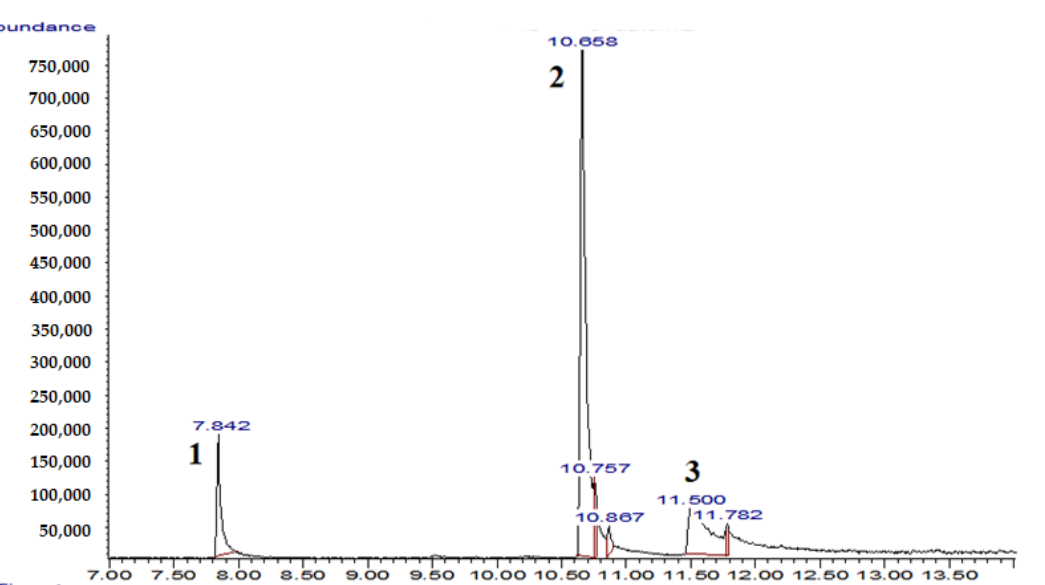
Figure 8. Chromatogram of the extract obtained during biotransformation of (–)-isopulegol (5 days) using R. rhodochrous IEGM 1362 in the presence of HNTs: 1 , (–)-isopulegol, 2 , metabolite m/z 170, 3 , metabolite m/z 184.